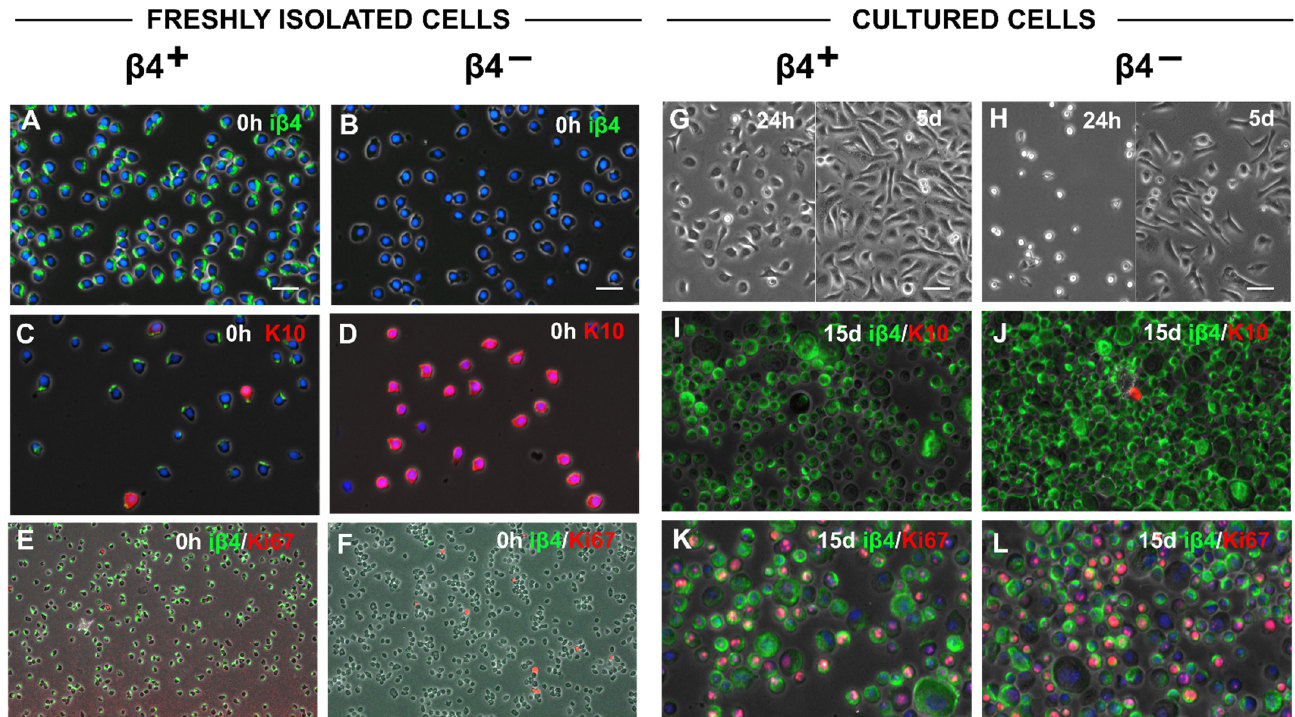
Figure 3. Both basal and suprabasal cells are activated during 2D culture in vitro. ( A – F ) Freshly isolated and i β 4-sorted keratinocytes were concentrated by cytospin and stained for different markers. ( A , B ) i β 4 staining (green) after sorting (0 h). i β 4 + cells were positive ( A ), i β 4 − were not ( B ). Nuclei were stained with Hoechst. ( C , D ) K10 staining (red) after sorting (0 h). i β 4 + cells were negative for K10 ( C ), with few exceptions (the residual green i β 4 signal is due the sorting procedure), i β 4 − were positive ( D ). Nuclei were stained with Hoechst. ( E , F ) Ki67 (red)/i β 4 (green) double-staining after sorting (0 h). More Ki67-positive cells were found in the i β 4 − fraction. ( G – L ) Freshly isolated and i β 4-sorted keratinocytes were cultured for two weeks before being removed from the culture plate, concentrated by cytospin and stained for different markers. ( G , H ) Phase-contrast pictures showing the morphology of cultured cells 24 h and 5 days after sorting. ( H ) i β 4 − keratinocytes went